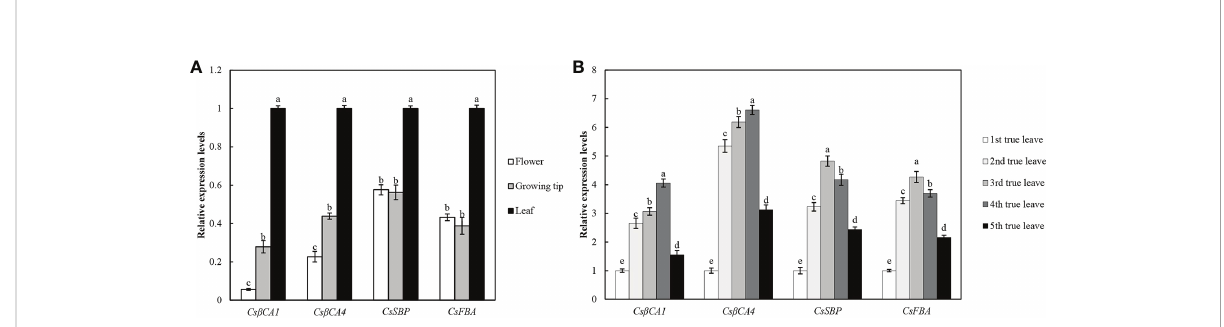
FIGURE 2 Expression patterns of target genes in different tissues in cucumber. (A) Tissue-speci fi c expression pro fi les of four genes in different tissues, including leaf, fl ower, and growing tip tissue. The relative expression level in fl ower and growing tip were determined with the expression level of leave as internal standards to normalize. (B) Expression pro fi les of four genes in fi ve full expanded true leaves. Small letters represent signi fi cant differences ( P < 0.05). Labels in the fi gures and tables below are the